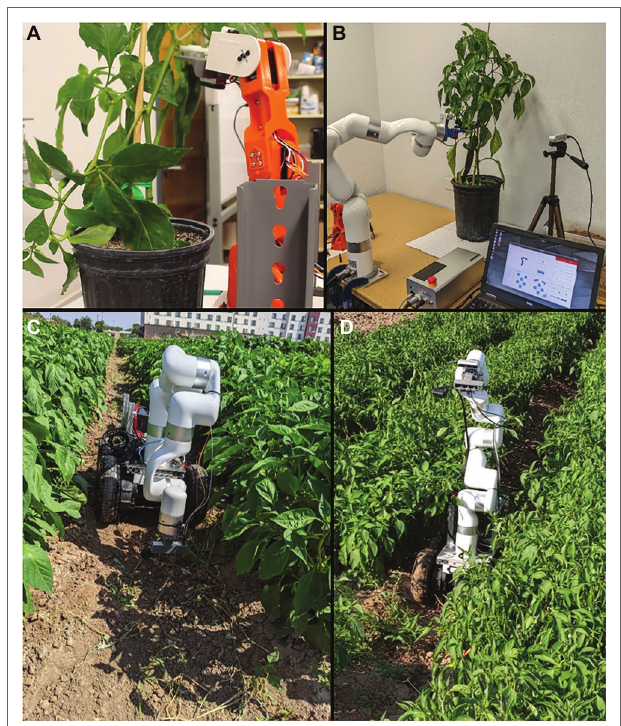
FIGURE 3 | (A) A 5 degrees of freedom (DoF) robotic arm with a cutter end- effector harvesting green chile peppers in an indoor setting. (B) A 6 DoF robotic arm with integrated wrist camera and a cutter end-effector identifies the location of the stem and harvest green chile pepper. (C) Robotic soil moisture and temperature measurements at the NMSU’s Jose Fernandez Heritage Farm, Las Cruces, NM. (D) Image capturing and visual remote sensing using an autonomous ground mobile robotic arm in chile pepper testing field at the Leyendecker Plant Science Research Center, NMSU, Las Cruces,